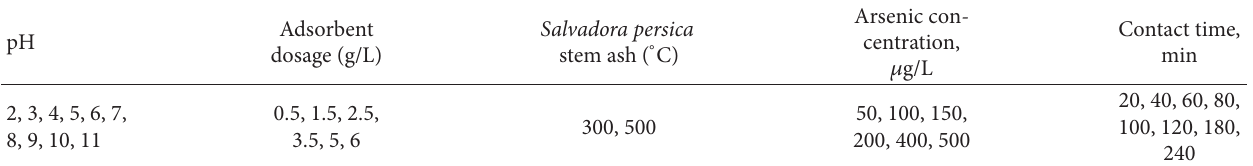
T 1: e ranges of experimental